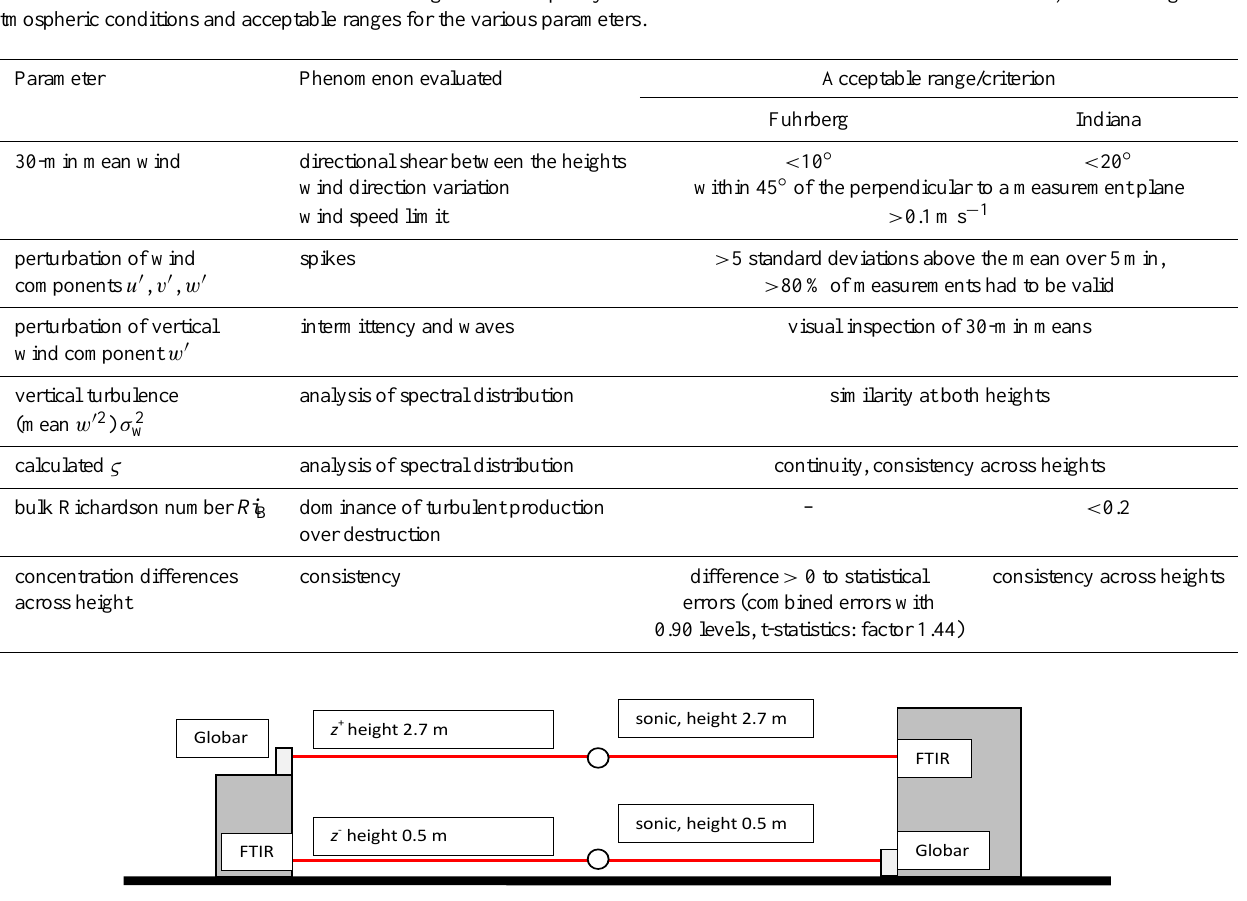
Figure 1. Configuration of the Fuhrberg experiments with FTIR spectrometers and radiation sources (globars) showing the measurement paths and sonic anemometers. Chamber measurements were made in about 10 m distance to the one end of the FTIR paths. The measurement volume was oriented in north-south direction.